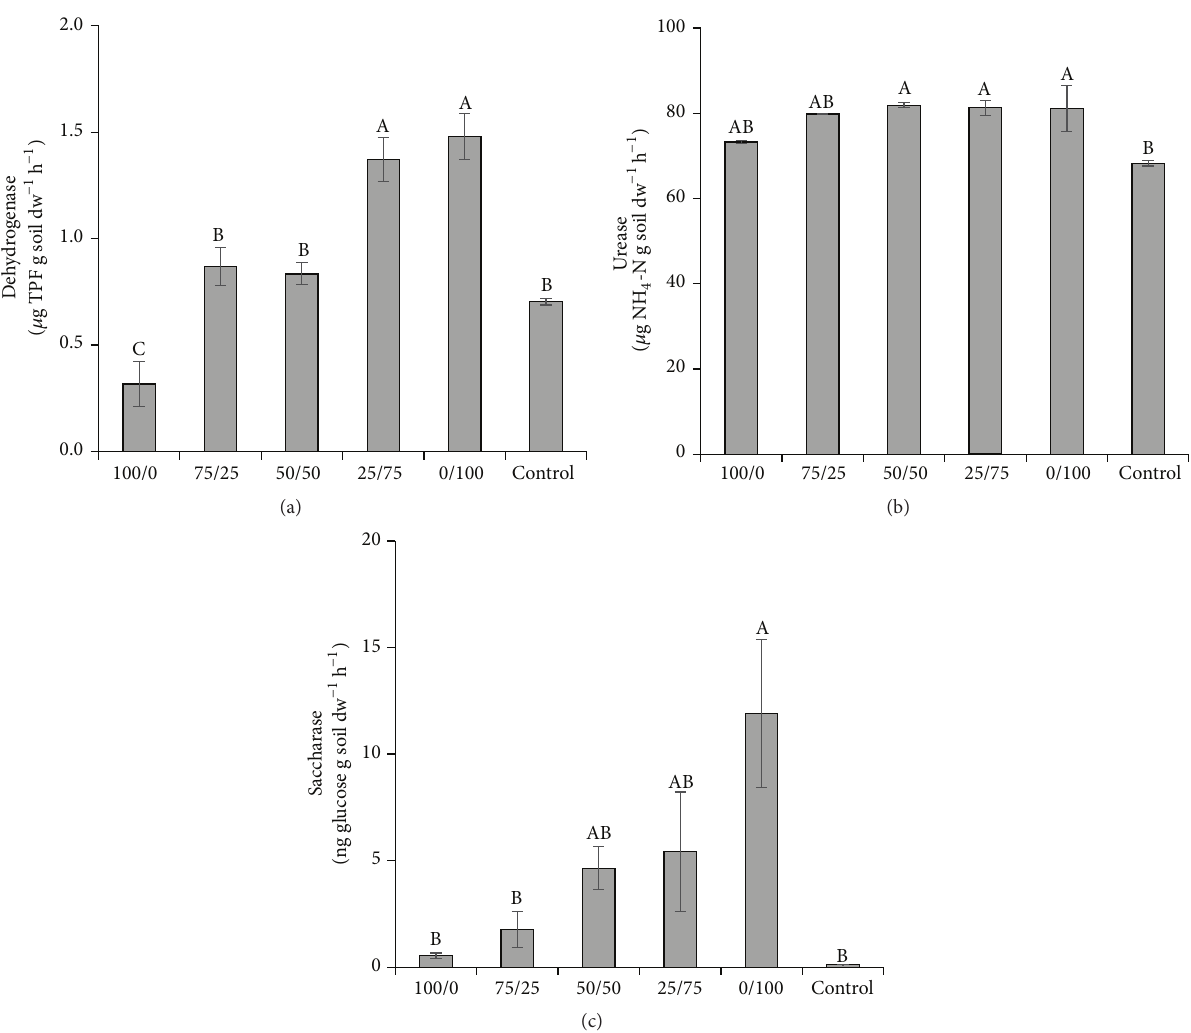
Figure 4: Enzyme activities of dehydrogenase (a), urease (b), and saccharase (c) in soil amended with AMC of inorganic/organic = 100/0, 75/25, 50/50, 25/75, and 0/100 and without AMC (control) after 184 days of incubation. Vertical bars indicate the standard error. Different letters indicate significant difference at 𝑃 < 0.05